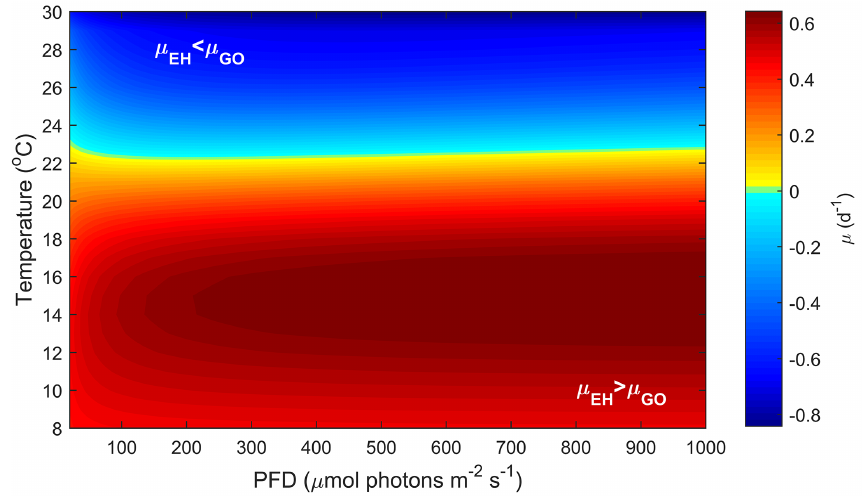
Figure 4. Predicted difference in growth rates between G. oceanica and E. huxleyi across a light range of 50–1000µmolphotonsm − 2 s − 1 and a temperature range of 8–30 ◦ C at 400µatm f CO 2 based on Eq.